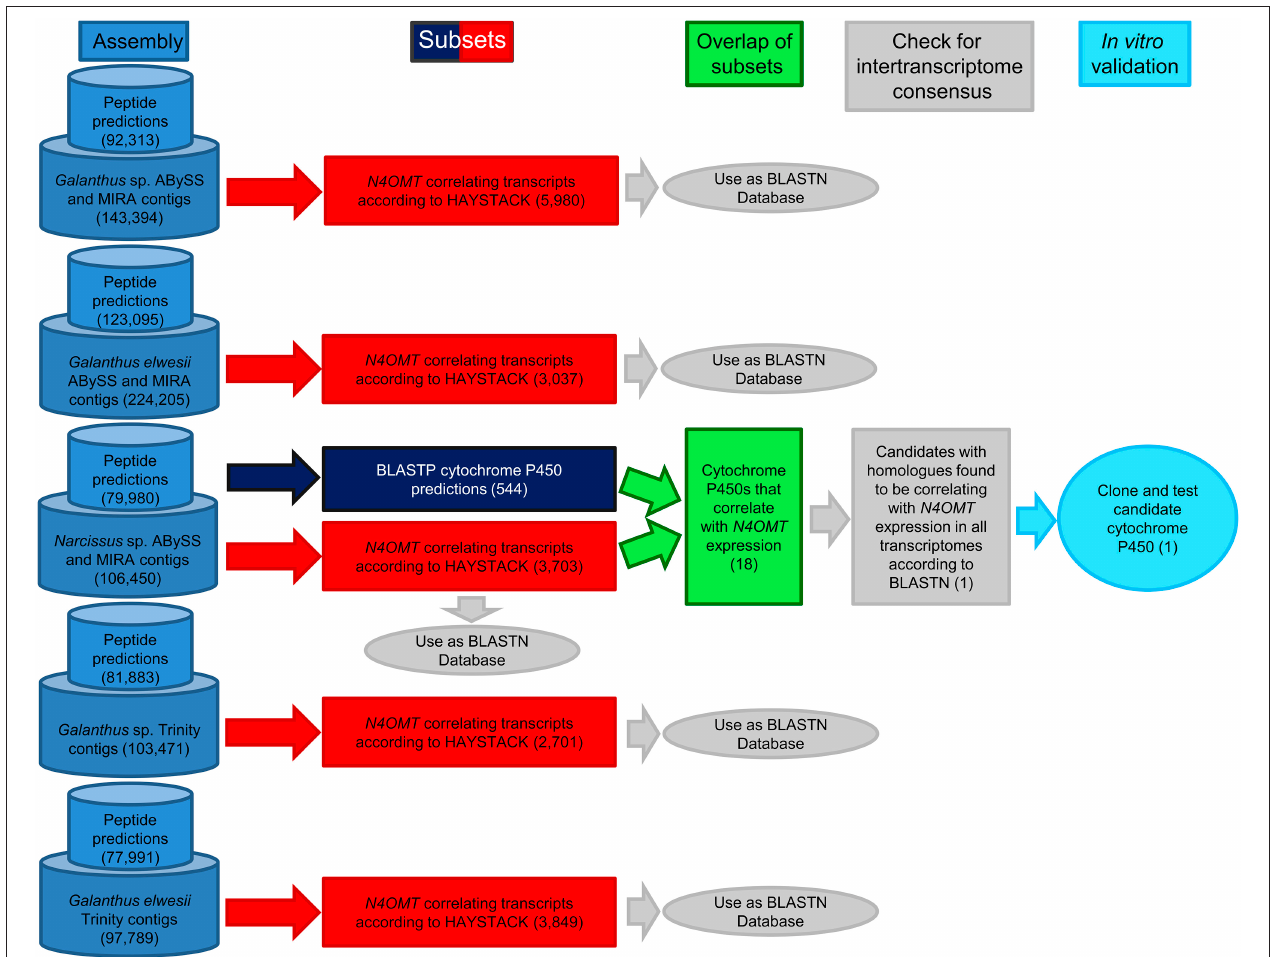
FIGURE 3 | Work-flow for identification of candidate cytochrome P450 enzymes. Following the generation of transcriptome assemblies, cytochrome P450 enzymes were identified with BLASTP (Navy blue) and genes correlating with N4OMT were identified with HAYSTACK (Red). The genes present in both lists makeup the initial candidate gene list (Green). Homologs of these genes were identified in the N4OMT correlating lists of the other transcriptomes using BLASTN (Gray). Candidates with homologs in all five N4OMT correlating lists were cloned from N. sp. aff. pseudonarcissus, Narcissus sp. (light blue). The analysis for the N. sp. aff. pseudonarcissus ABySS and MIRA assembly is completely diagrammed to illustrate the process followed in every assembly. The number of transcripts selected in each step is in parentheses. The N. sp. aff. pseudonarcissus Trinity assembly is excluded from this work-flow due to its poor quality.